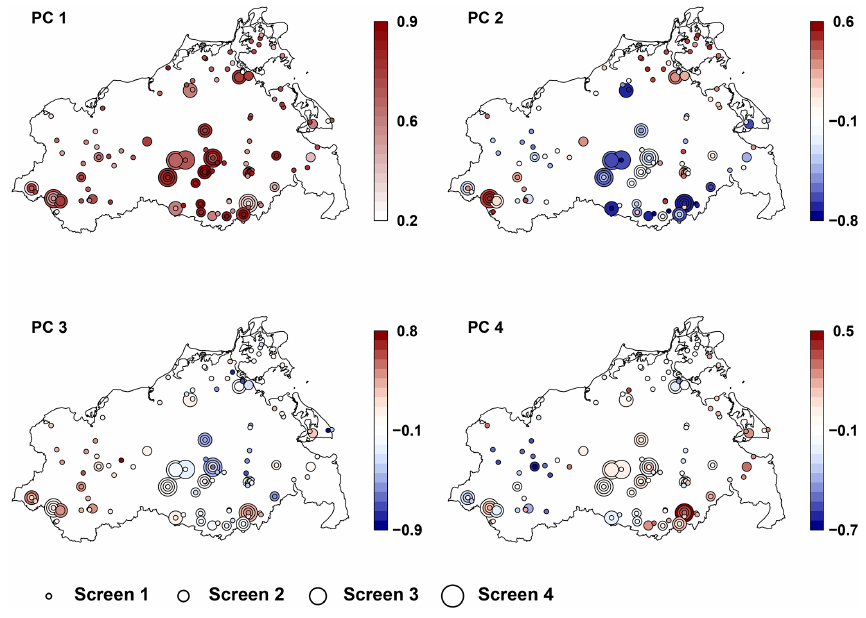
Figure 5. Spatial patterns of loadings of the stable PCs 1 to 4.